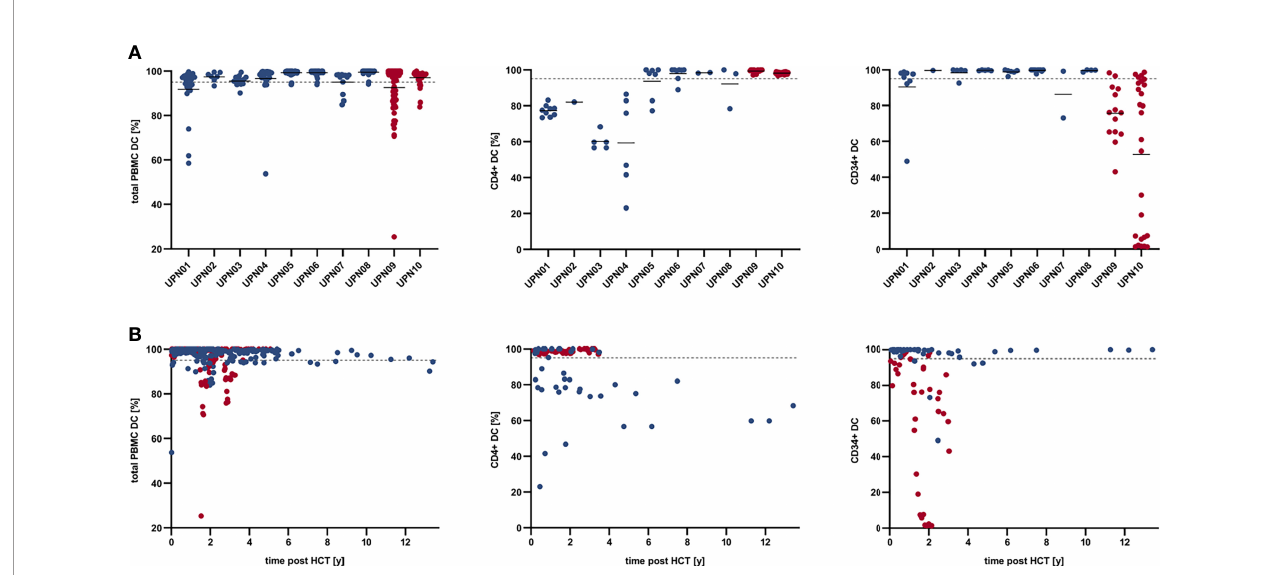
FIGURE 2 | Total PBMC, CD4 + , and CD34 + donor chimerism kinetics in MC patients who are alive in continuous CR (blue) and MC patients who deceased due to relapse (red). (A) Total PBMC, CD4 + , and CD34 + donor chimerism per patient; solid lines indicate mean total PBMC, CD4 + , and CD34 + DC per UPN. (B) Total PBMC, CD4 + , and CD34 + donor chimerism over time post HCT. Dashed line indicates 95% DC. CR, complete remission; DC, donor chimerism; HCT, hematopoietic cell transplantation; MC, mixed chimerism; PBMC, peripheral blood mononuclear cells; UPN, unique patient number.